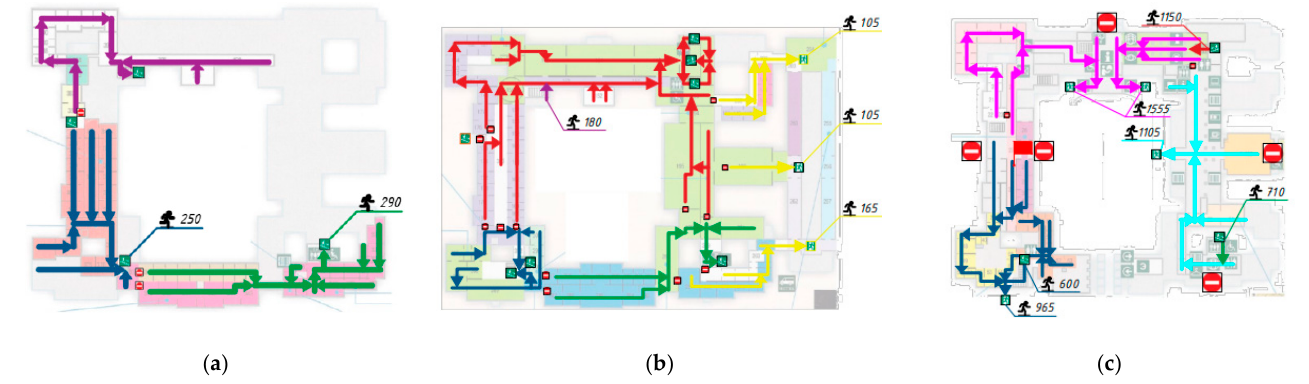
Figure 16. Scheme of evacuation of people from the Winter Palace for the scenario “Fire in the foyer of the Wooden Staircase”: ( a ) for the 3rd floor; ( b ) for the 2nd floor; and ( c ) for the 1st floor.